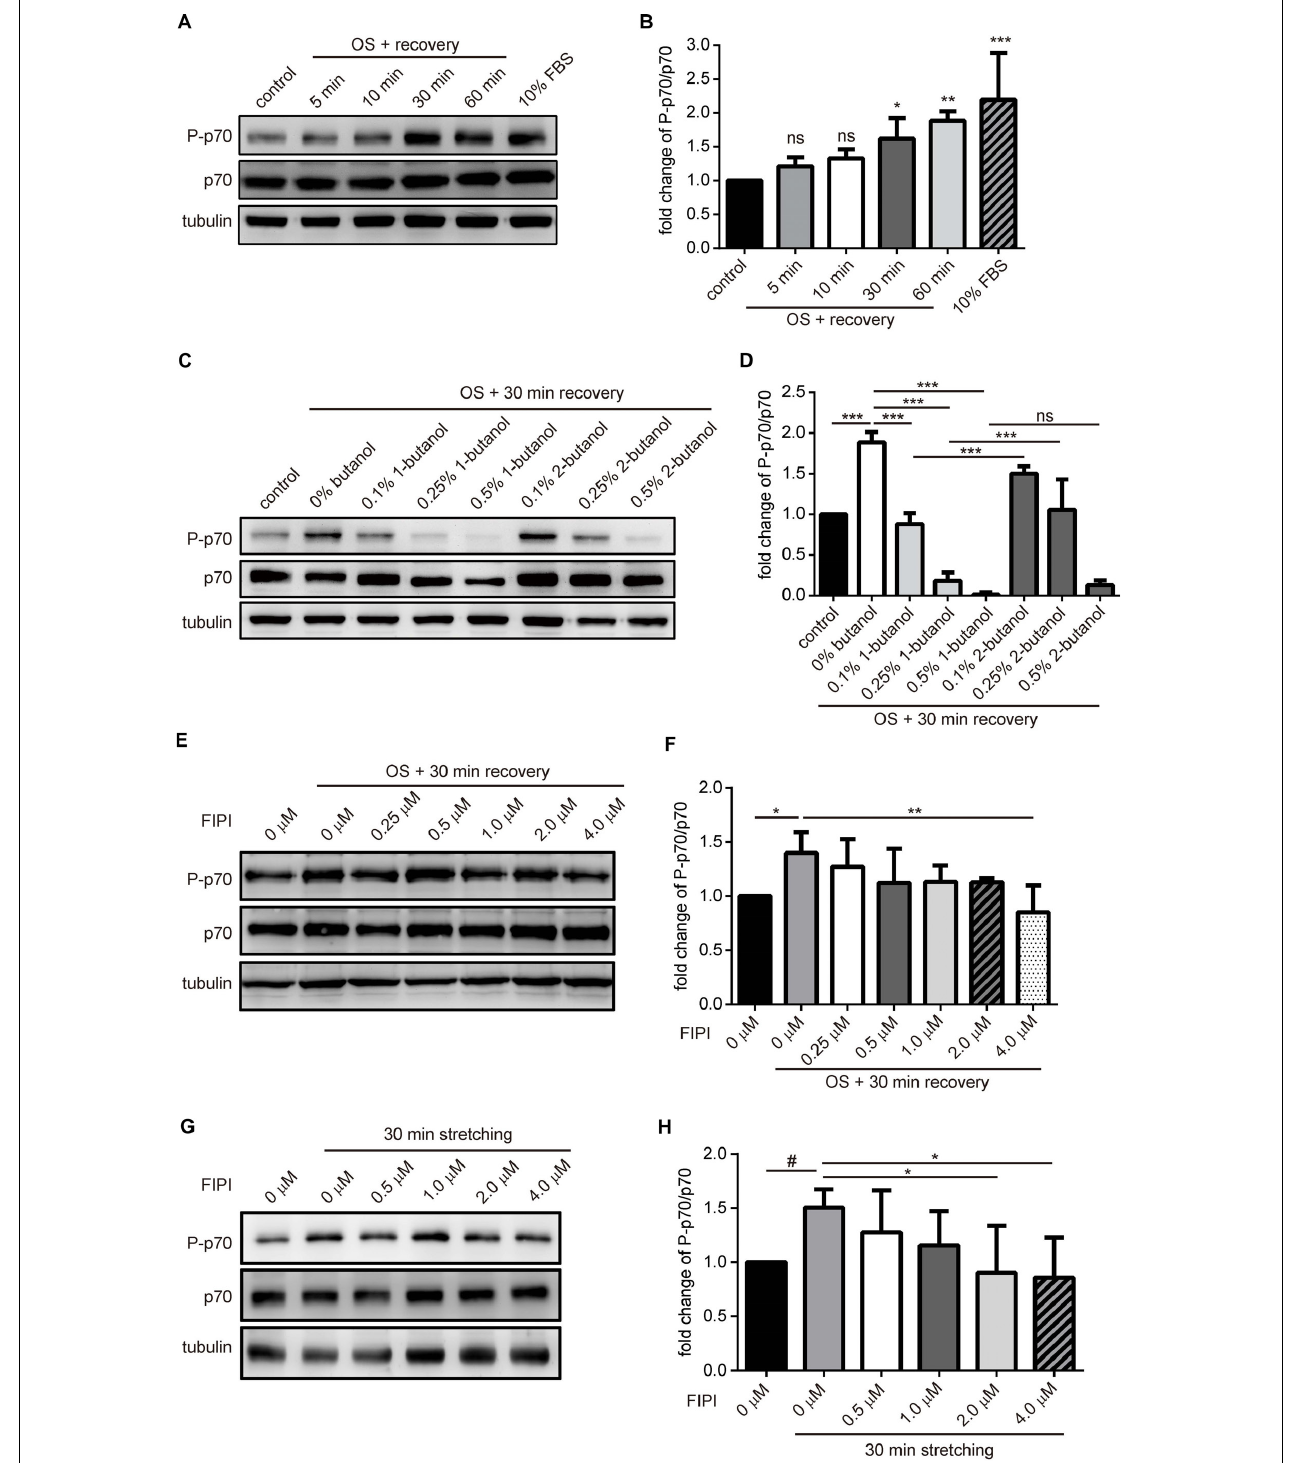
FIGURE 4 | mTOR signaling is activated in myotube upon tension fluctuation. (A,B) mTORC1 signaling upon OS treatment. C2C12-derived myotubes were treated with 2-min of 0.25X PBS and followed by indicated period of time for recovery with isotonic DM. Control was myotube incubated with DM without OS treatment whereas 10% FBS sample was myotube treated with 60-min of growth medium. Cell lysates were analyzed with Western blotting to quantify p70 phosphorylation (A) . Three independent experiments of the fold change of P-p70/p70 upon OS treatment were quantified with ImageJ and shown as fold change compared